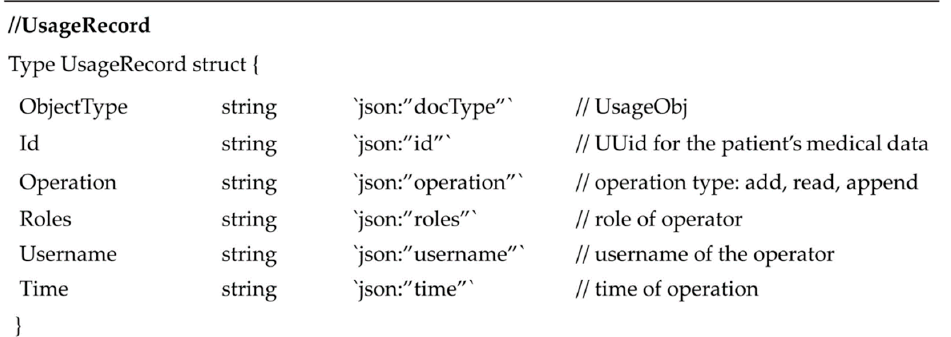
Figure 5. Data type of Case.